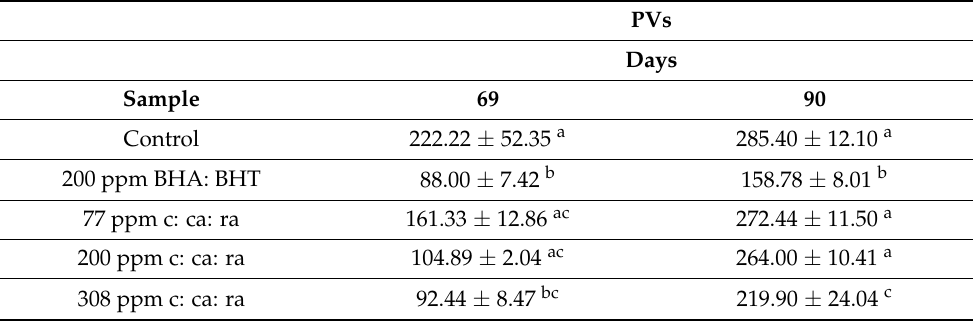
Table A1. PVs of the FFMPs after accelerated storage (40 ◦ C, RH 23%) for 69 and 90 days, with or without the addition of antioxidants 1, 2, 3, 4 .